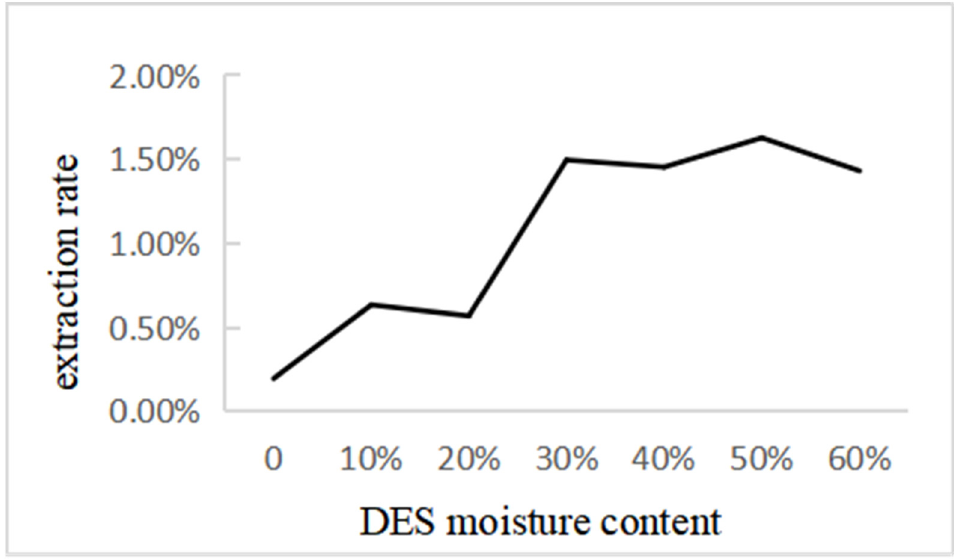
Figure 5. Effect of DES moisture content on the extraction yield of coumarins.